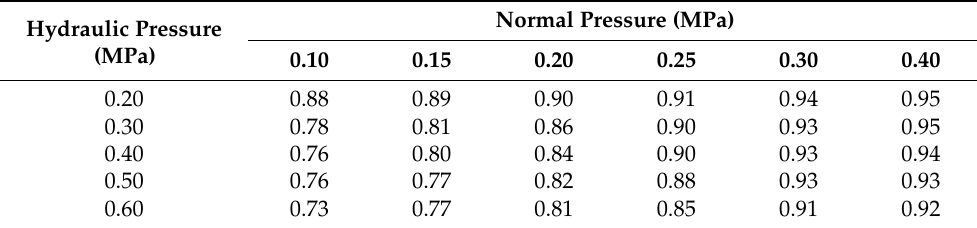
Table 4. Rate of decline in seepage flow under different water pressure and normal pressure conditions. Hydraulic